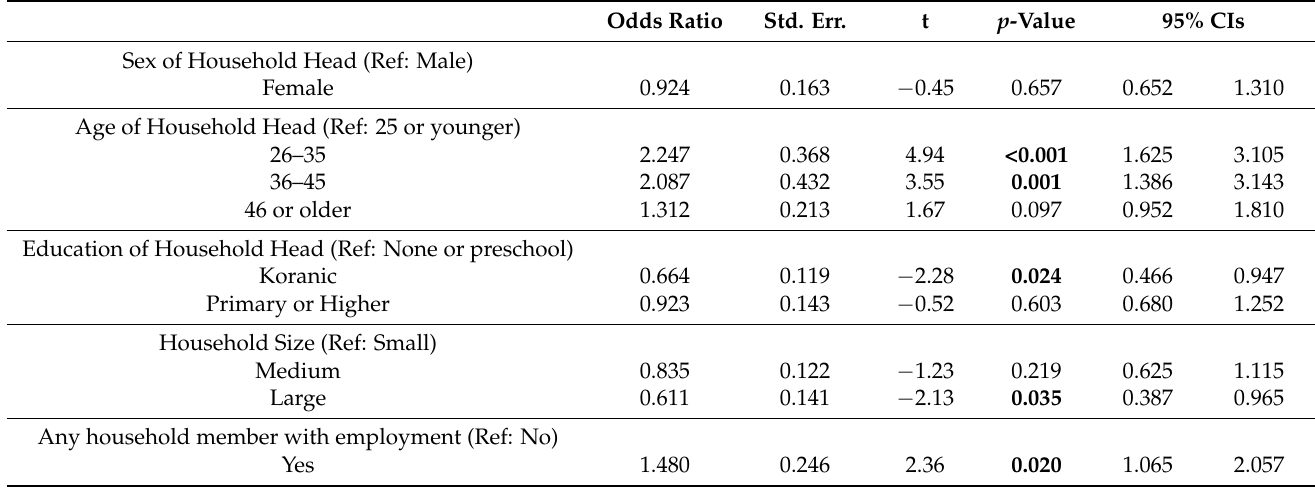
Table 3. Results of multiple logistic regression on mosquito net ownership. n = 2091. Notes: Bolded = p -value <